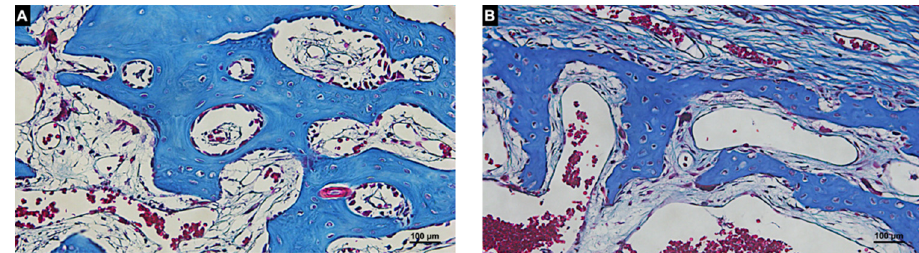
Figure 9. Histologic photomicrography of the Membrane region in the autogenous ( A ) and xenogenous ( B ) graft after 20 days of healing. New bone was found forming from the graft surface in the autogenous group and in close contact to the trabeculae of the graft in the xenogenous group. Masson’s Trichrome stain; magnification 200×.